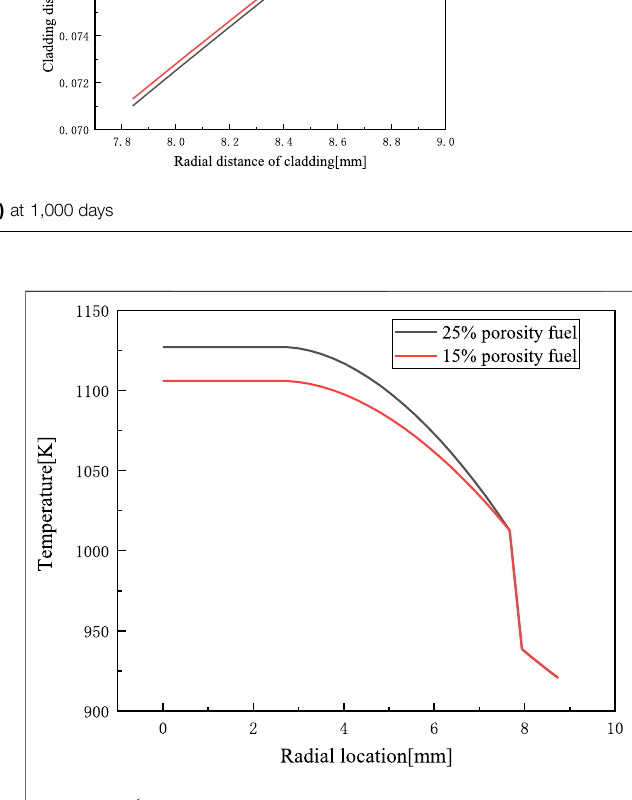
FIGURE 11 | The in fl uence of 25 and 15% porosity in heat transfer